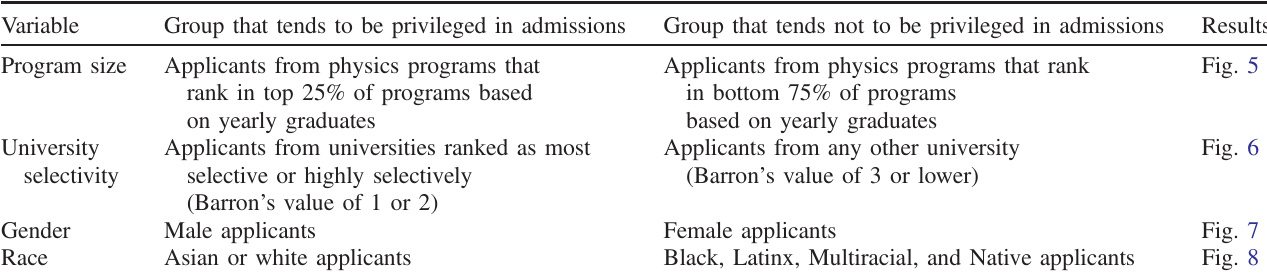
TABLE I. Summary of the comparisons we analyzed, which group needs to stand out and which does not, and the figure number showing the